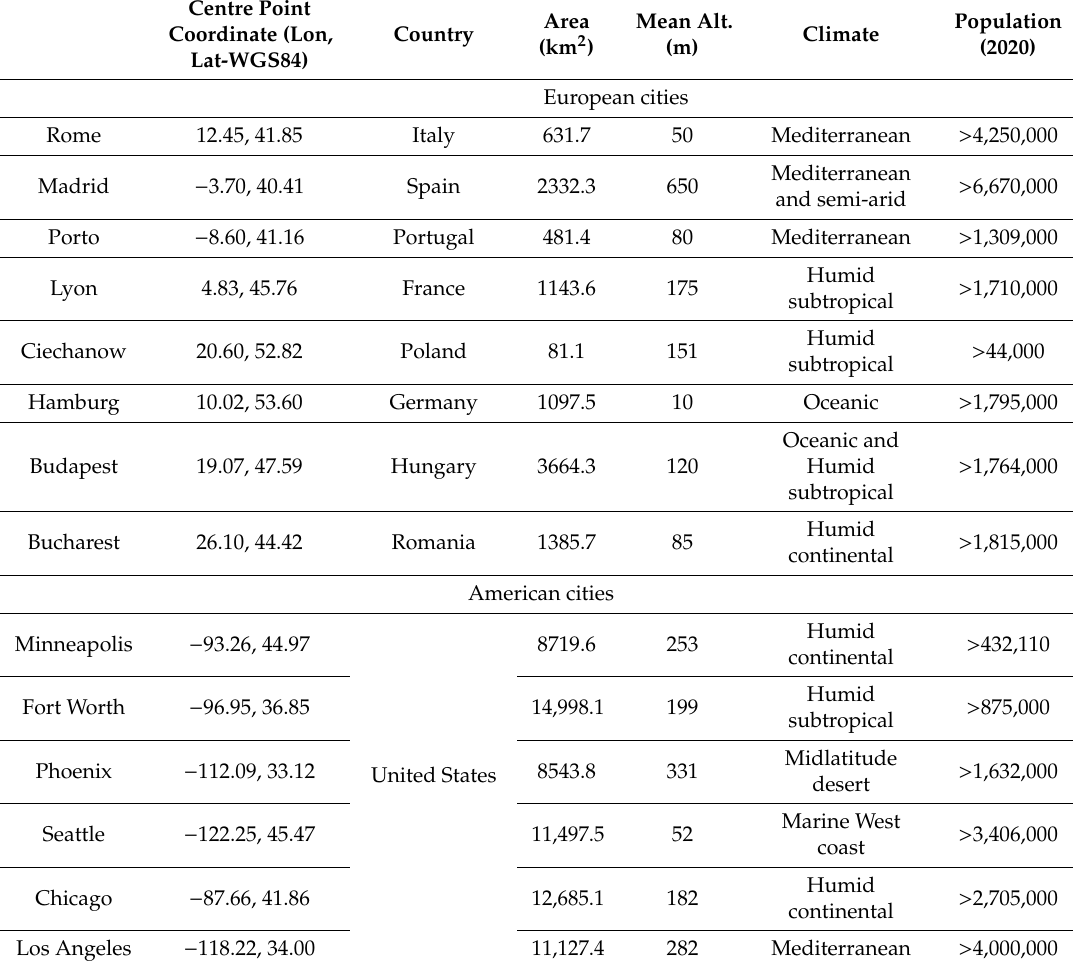
Table 1. Summary characteristics of selected cities in the USA and